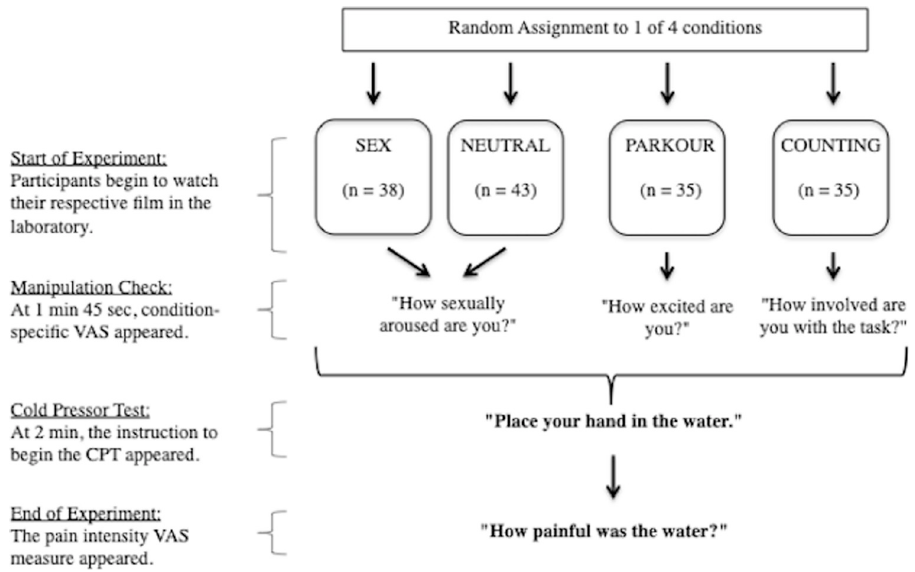
Fig 1. Flow diagram: Experiment, step-by-step procedure.